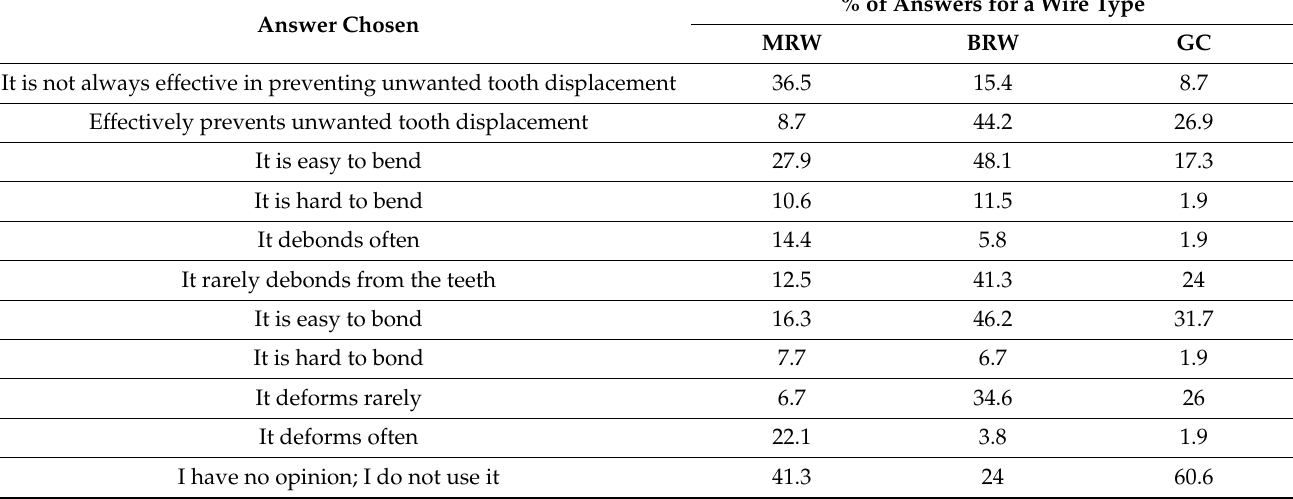
Table 1. The characteristics of the wires according to the respondents.